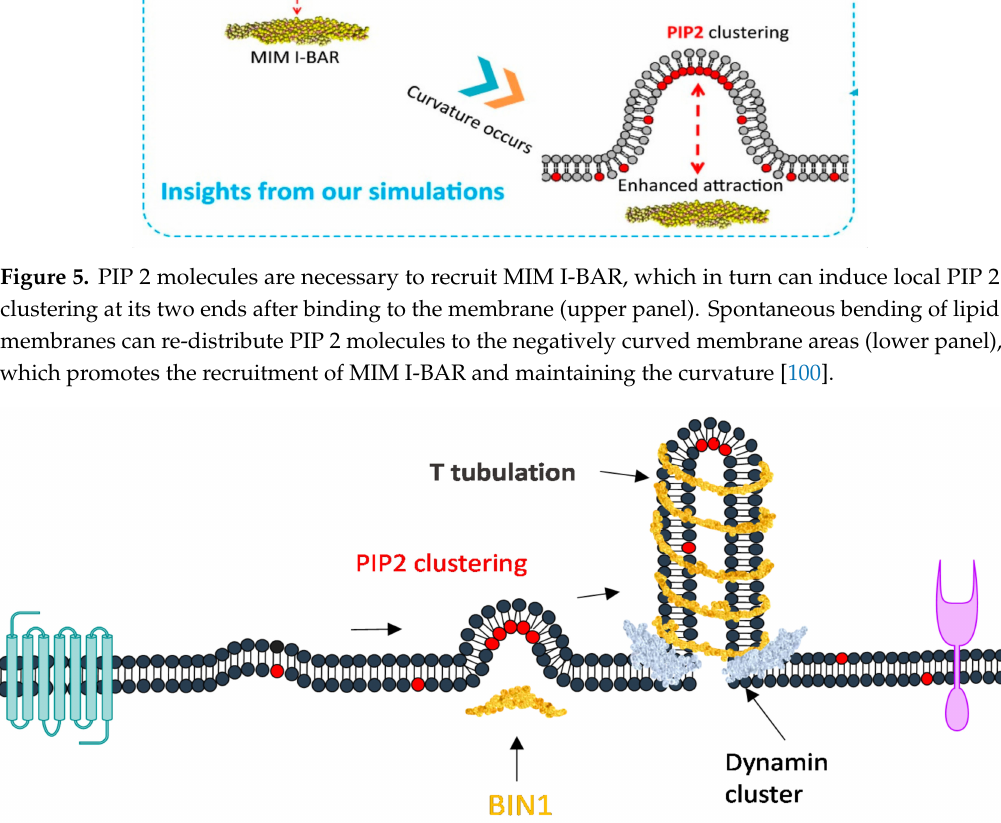
Figure 6. BIN1 mediated membrane tubulation. BAR domain proteins are able to both sense and induce membrane curvature. BIN1 clustering with PIP2 that promote dynamine recruitment and thus forms T- tubule. Binding of dynamin depends upon the amount of PI(4, 5)P 2 and enhanced by